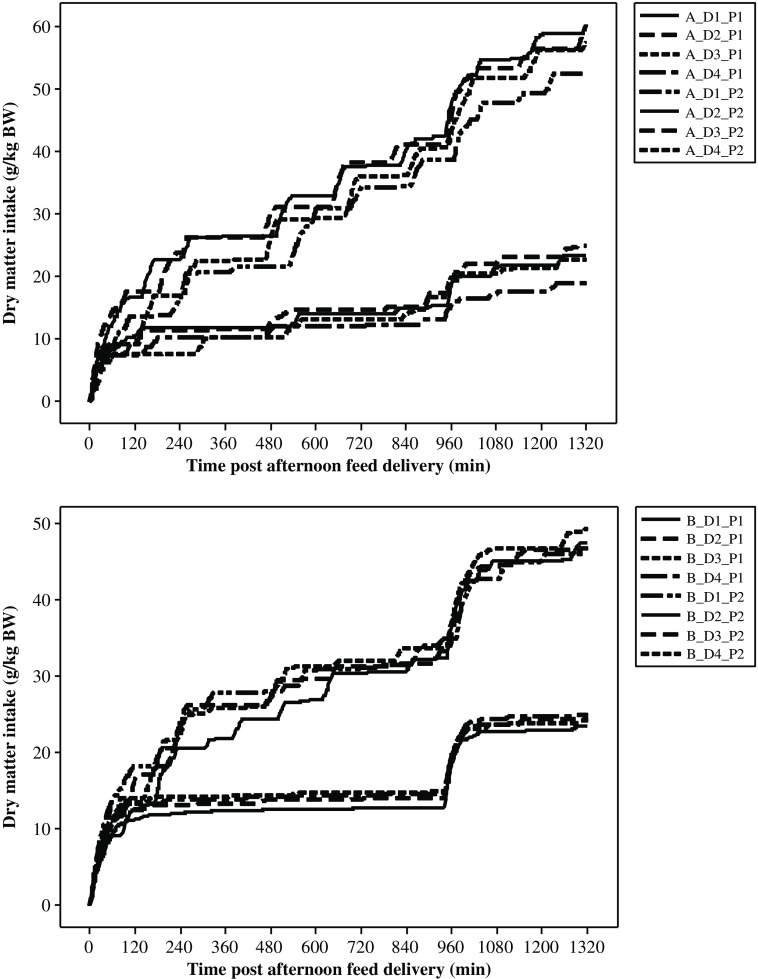
Daily cumulative DMI (g/kg BW) for goats A and B measured during 4 days (D1 to D4) in two periods (P1 end of first gestation and P2 middle of first lactation). In each figure, curves at the bottom refer to P1 and those at the top to P2. DMI = dry matter intake.